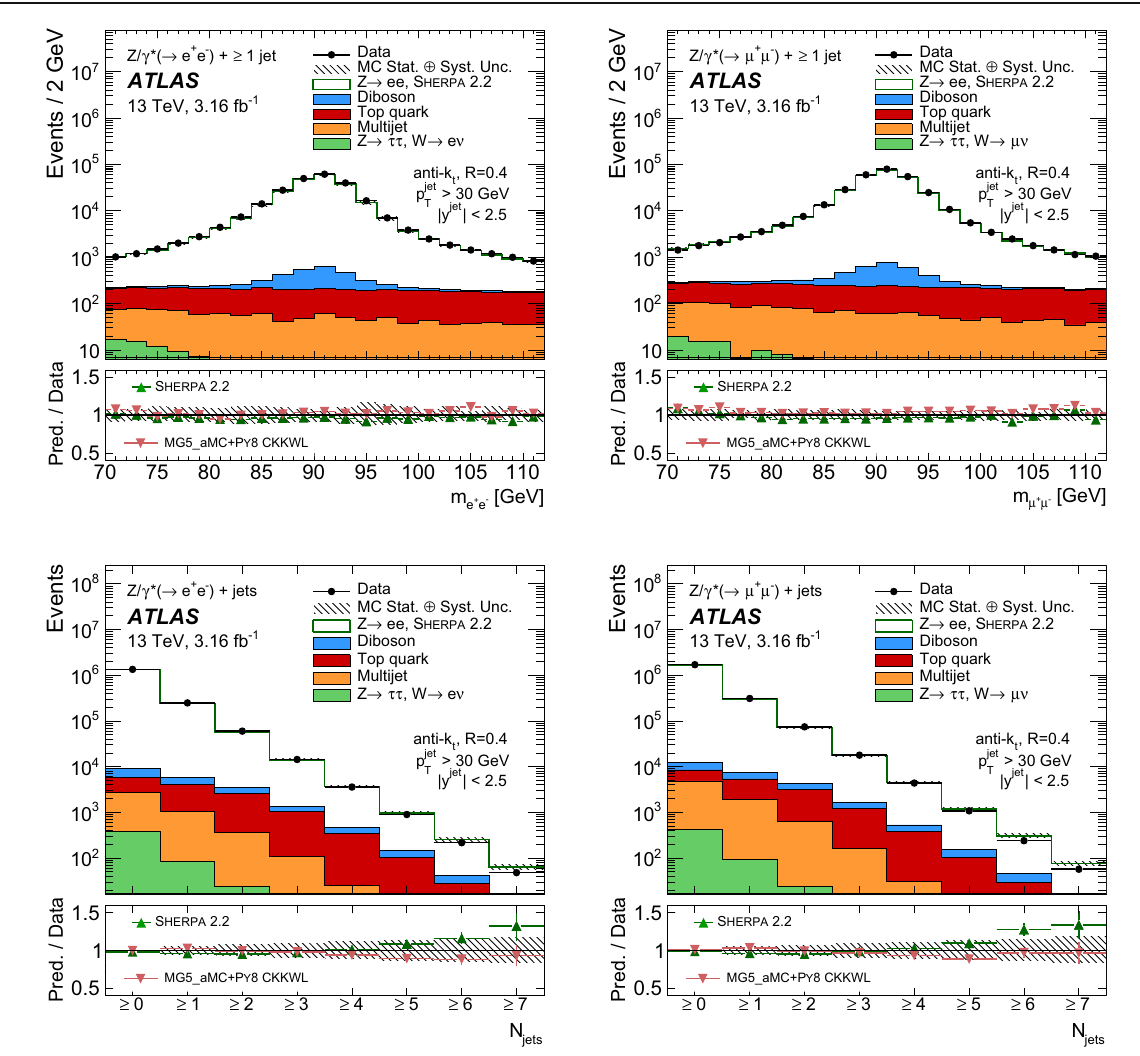
the anti- k t algorithm [68] with radius parameter R = 0 . 4 for final-state particles with decay length c τ > 10mm, exclud- ing the dressed Z -boson decay